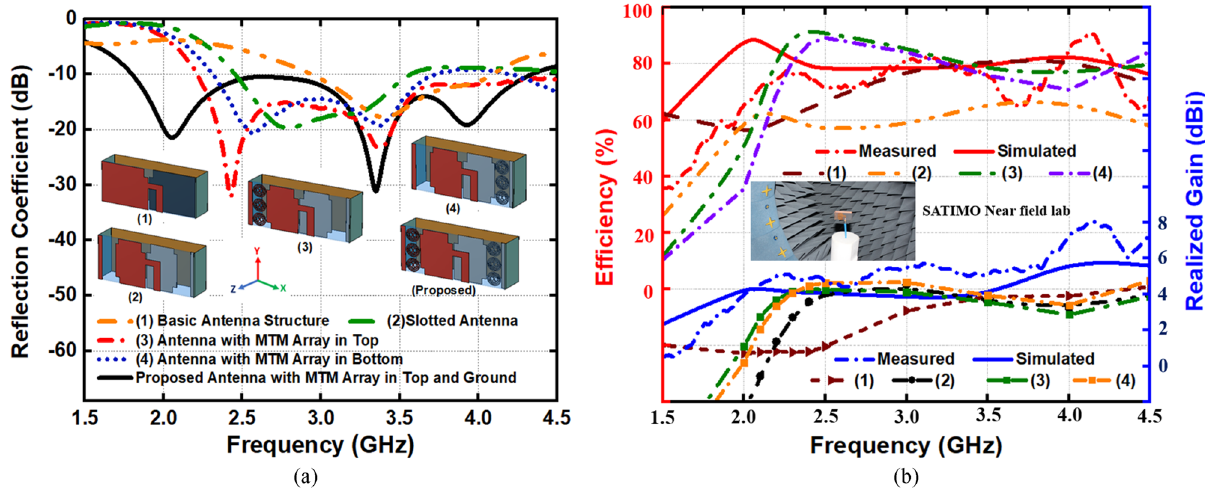
Figure 5. Evolution of the proposed MTM-loaded 3D-antenna ( a ) scattering parameters. ( b ) Efficiency and realized